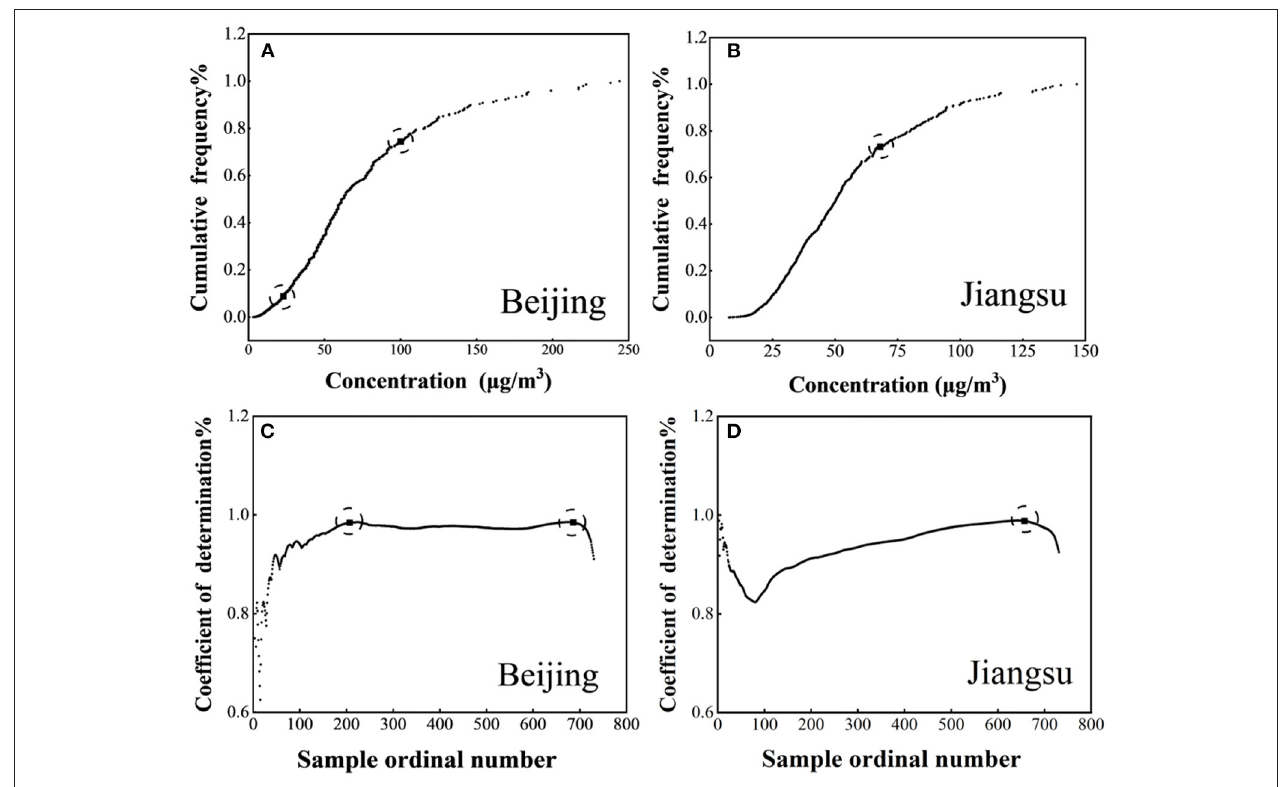
FIGURE 1 | Cumulative frequency distribution (A,B) and inflection point (C,D) of Beijing and